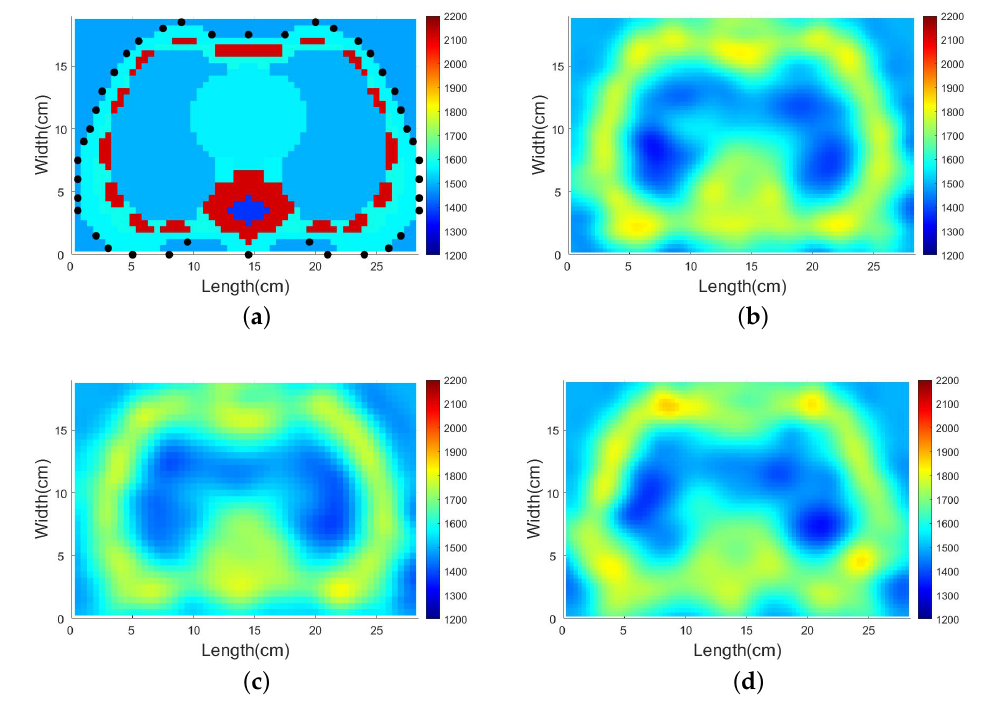
Figure 11. The new transucer array and the SDM inversion results with different array and different grid. ( a ) The new transducer array with 40 transducers, ( b ) inversion result with previous array and new grid, ( c ) inversion result with new array and previous grid, ( d ) inversion result with new array and new grid. Colorbar: 1200–2200